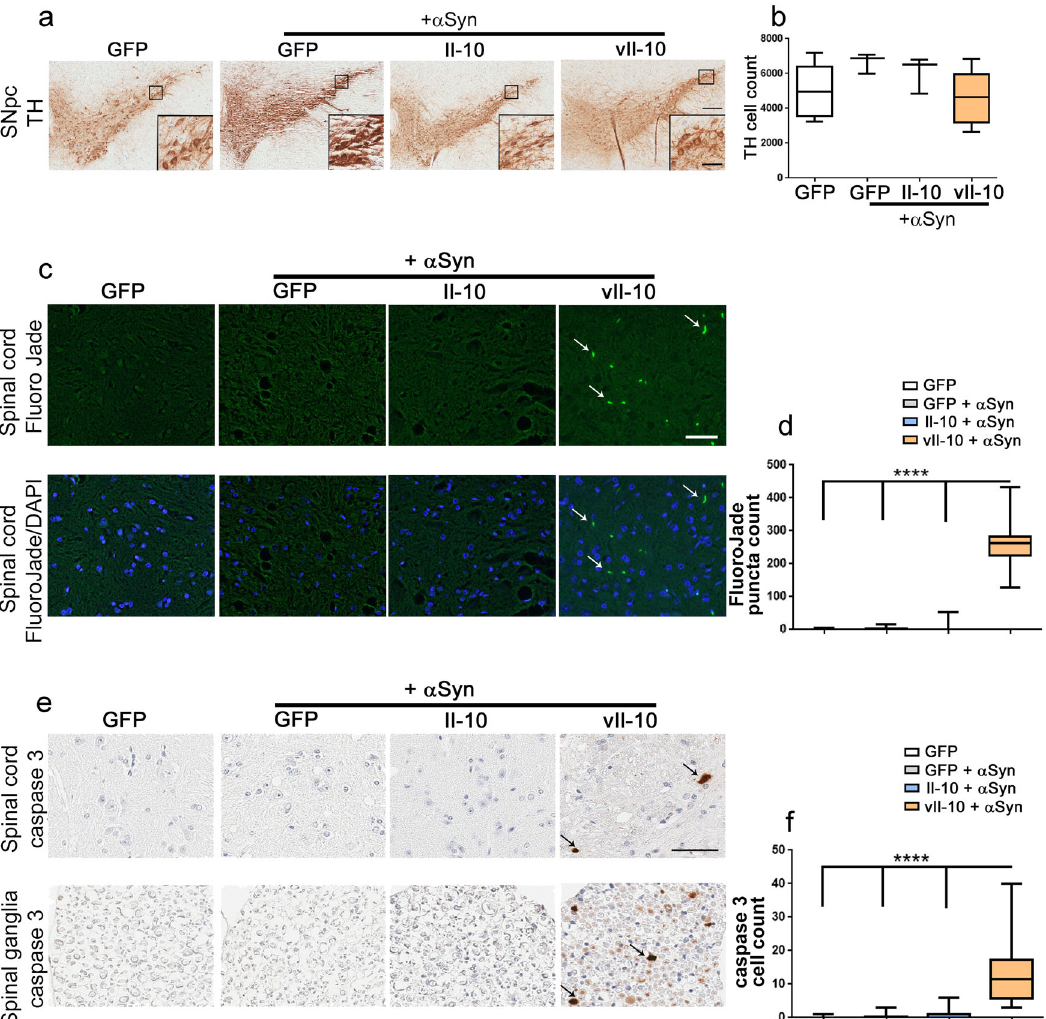
Fig. 6 Cell death analysis in α Syn aggregate-seeded hemizygous M83 + / − mice. a , b Midbrains of vehicle-injected AAV-GFP-expressing M83 + / − mice or α Syn aggregate-seeded M83 + / − mice expressing AAV-GFP, AAV-Il-10, or AAV-vIl-10 were stained for tyrosine hydroxylase (TH) ( a ), and the number of TH-positive dopaminergic neuronal cell bodies was manually counted ( b ). Scale bar, 200 µm (main panel), 50 µm (inset). n = 3 – 6 mice/group; one-way ANOVA. c – f Cell death was analyzed in the lumbar spinal cord of M83 + / − mice. Punctate Fluoro-Jade C staining was observed in the vIL-10-expressing α Syn-seeded M83 + / − mice indicated by arrows ( c , top panel). The bottom panel depicts a dual-color image incorporating the nuclear stain DAPI. The number of Fluoro-Jade C-labeled puncta was manually counted ( d ). Anti cleaved caspase 3 antibody was used to stain the spinal cord ( e , top panel) and accompanying spinal ganglia ( e , bottom panel) of mice. The number of cleaved caspase 3-positive cells from the spinal cord and spinal ganglia (arrows, e ) was manually counted ( f ). In the box plot, the whiskers extend from the minimum to maximum values, with the midline representing the median. Scale bar, 20 µm ( c ), 50 µm ( e ). n = 5 – 7 mice/group. One-way ANOVA, **** P <